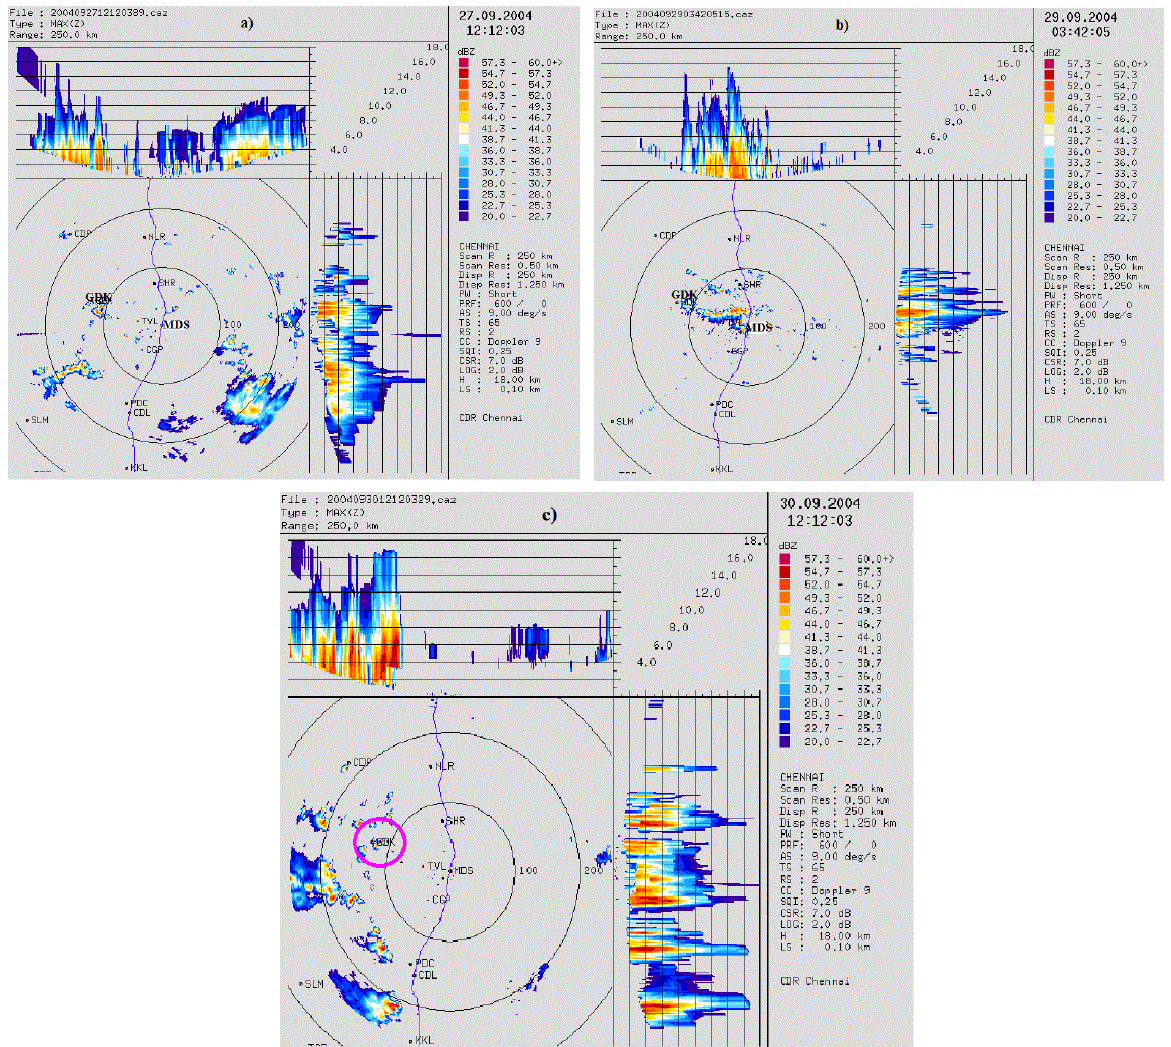
Fig. 2. Doppler Weather Radar images from Chennai on (a) 27 September 2004 at 17:42:03LT, (b) 29 September 2004 at 09:12:05LT and (c) 30 September 2004 at 17:42:03LT, corresponding to events I and II, respectively. Figure 2. Doppler Weather Radar images from Chennai on a) 27 September 2004 at 17:42:03 643 LT, b) 29 September 2004 09:12:05 LT and c) 30 September 2004 17:42:03 LT corresponds to 644 this stage the magnitudes of the vertical updrafts and downdrafts are 2.64 m s − 1 and 4.19 m s − 1 (Fig. 5a event [I] and [II], respectively. 645